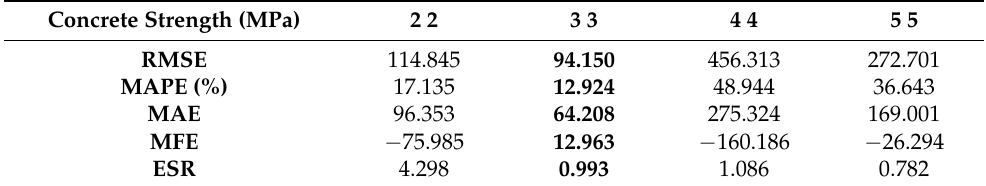
Table 10. Prediction results of the ANFIS model with the trapezoid membership function ‘tramf’.